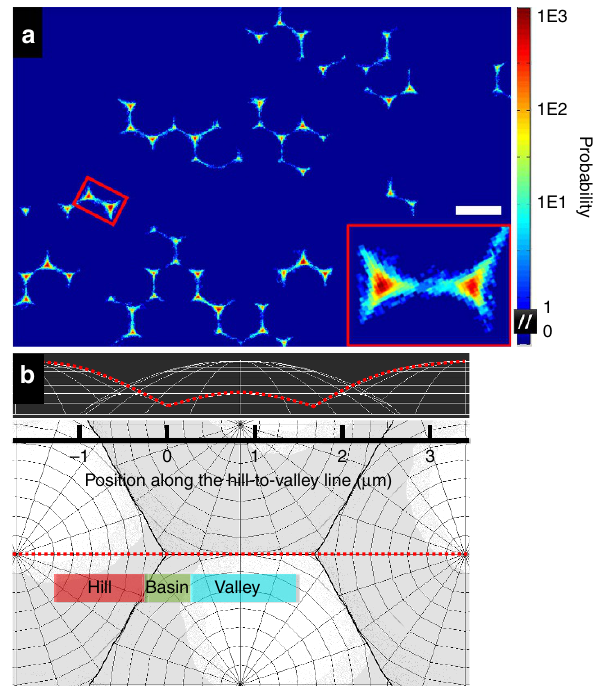
Figure 6 | Particle diffusion on the colloidal monolayer. ( a ) A positional probability map of multiple particles on the monolayer with a butterfly-like distribution enlarged in the insert. Scale bar, 3 m m. ( b ) Side and top views of the lowest surface that the top particle centre can explore. The red dash line is defined as the hill-to-valley line with hill, basin and valley regions indicated by different